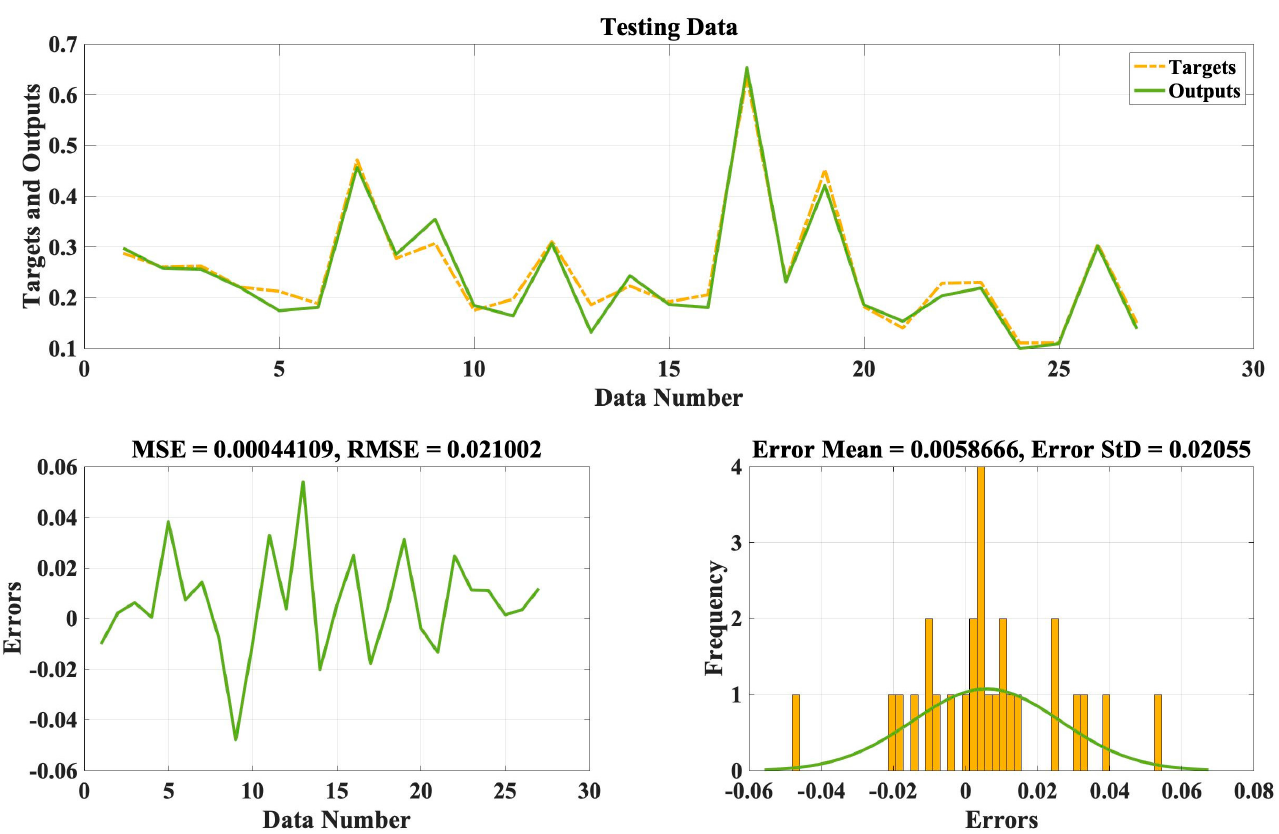
Figure 9. Results of the testing data based on normalized values.